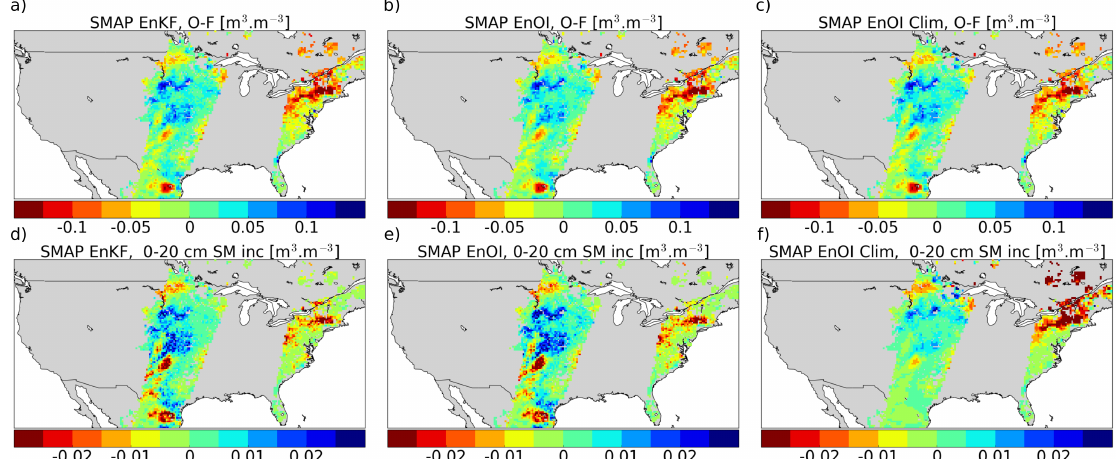
Figure 3. Instantaneous analysis output from 16 May 2015 at 1200 UTC for the EnKF, EnOI and EnOI-Clim; ( a – c ) observation-minus-Forecast (O-F) soil moisture residual (m 3 m − 3 ) for the model observation layer; ( d – f ) soil moisture increments (m 3 m − 3 ) for the top four soil layers 0–20 cm. Blue/red colours indicate positive/negative O-F residuals and